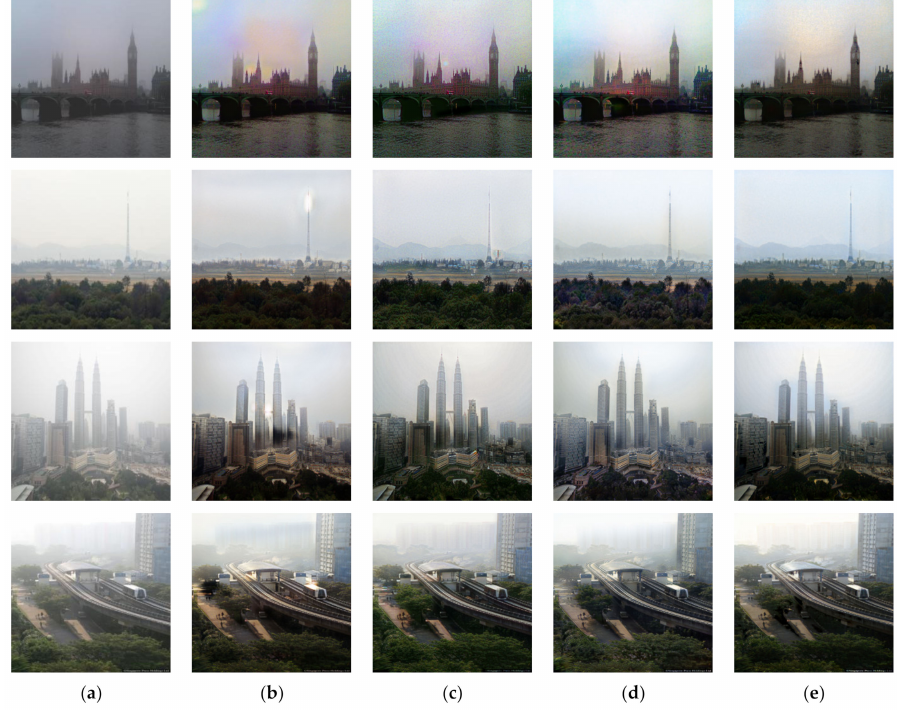
Figure 13. Visual results on real-world images: ( a ) hazy images; ( b ) no FFM and MSC; ( c ) FFM; ( d ) MSC; ( e ) FFM +